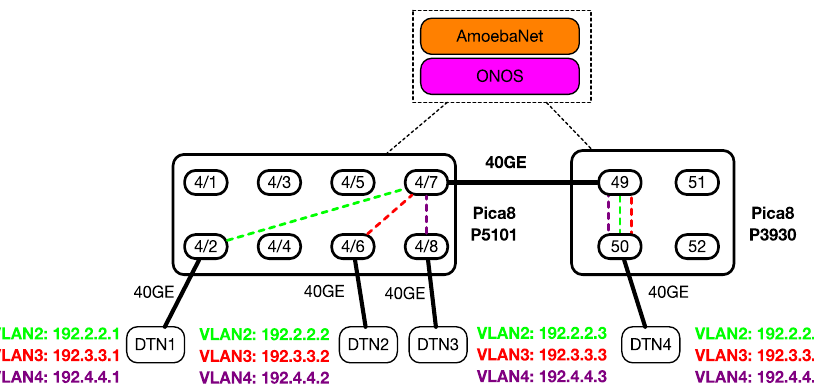
Figure 4. Extreme-scale data transfer topology in a single domain .